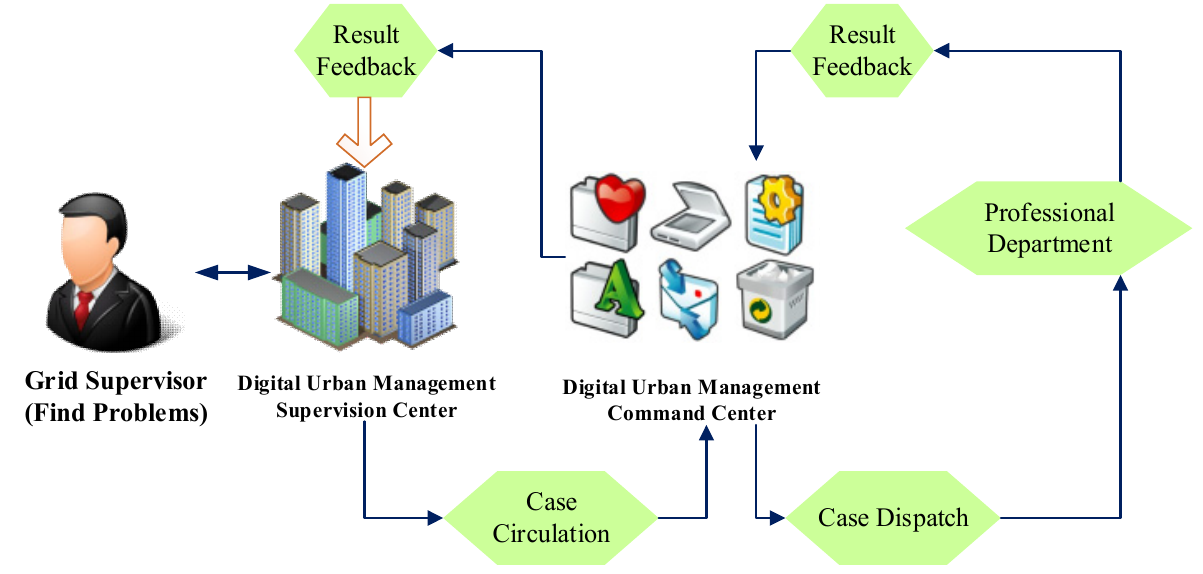
Figure 4. The basic flow of DC management.